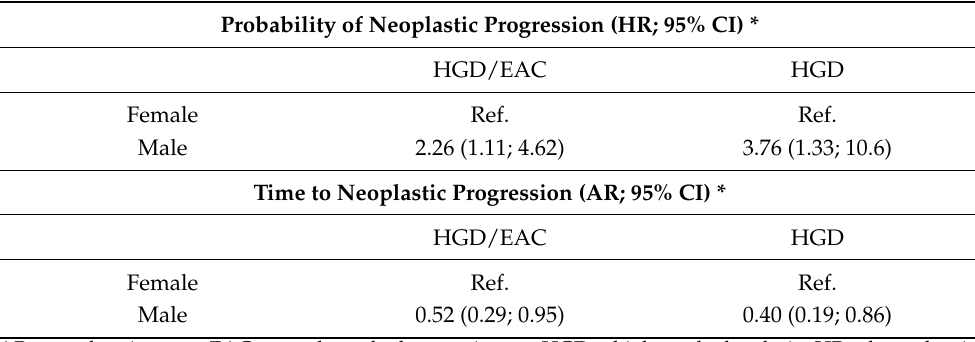
Table 3. Sex difference in the probability of and time to neoplastic